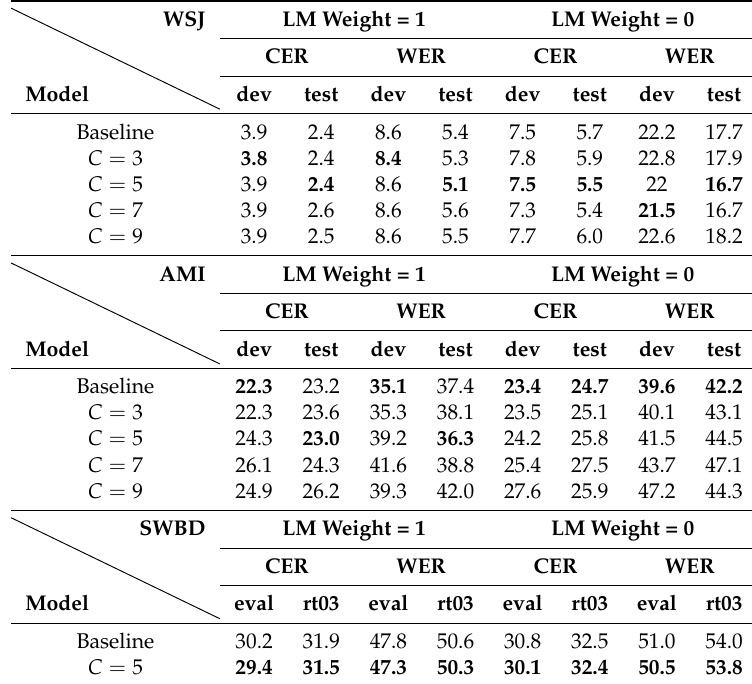
Table 2. The performances of the LA CTC/Attention for WSJ, AMI, and SWBD with different attentionwindow lengths. Additionally, the baseline is the results of